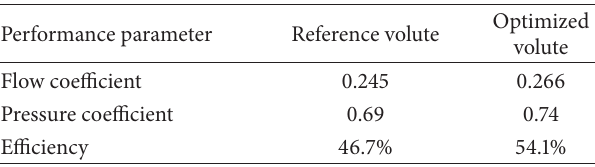
Table 1: Experimental results of reference and optimized volute of Baloni et al.